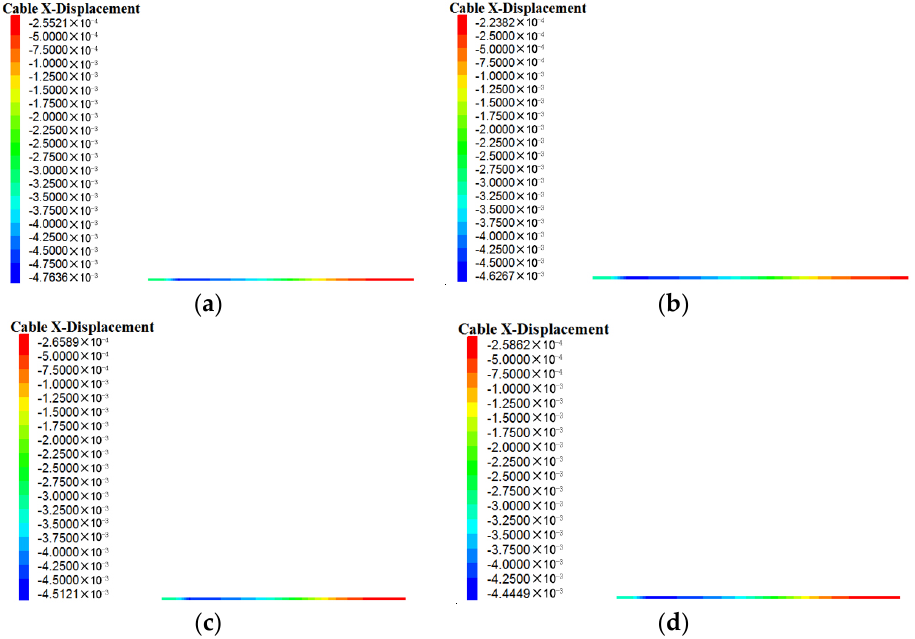
( b ) Figure 6. Simulation results of di ff erent values of L a. ( a ) Axial force of the bolt. ( b ) Shear force of the anchorage interface. When the value of the bed separation was 4 mm, the axial displacement cloud map of the bolt and the anchoring agent displacement cloud map corresponding to di ff erent L a values were as shown in Figures 7 and 8. It can be seen from Figure 7 that when the L a was di ff erent, the axial displacement of the bolt changed in the same law: the axial displace- ment of the bolt gradually increased from the right end to the left end, while the leftmost end of the anchor bolt gradually decreased due to the in fl uence of the tray. It can be seen